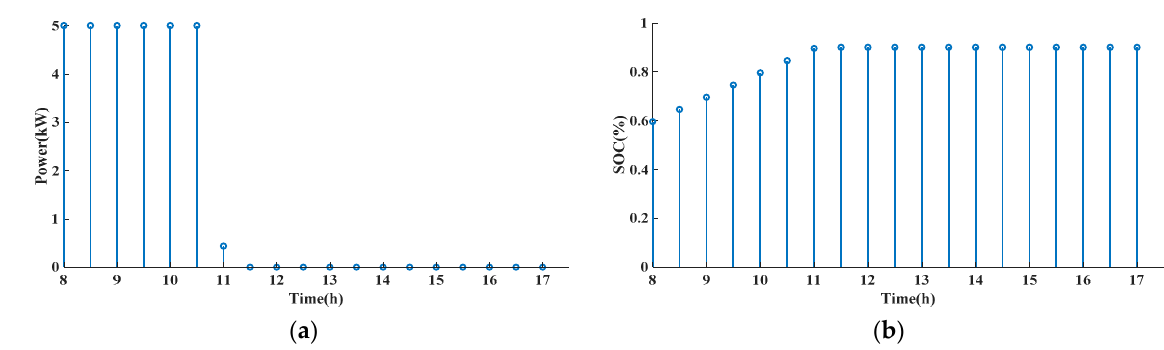
Figure 8. Typical charging curve of EV. ( a ) charging power; ( b ) SOC.